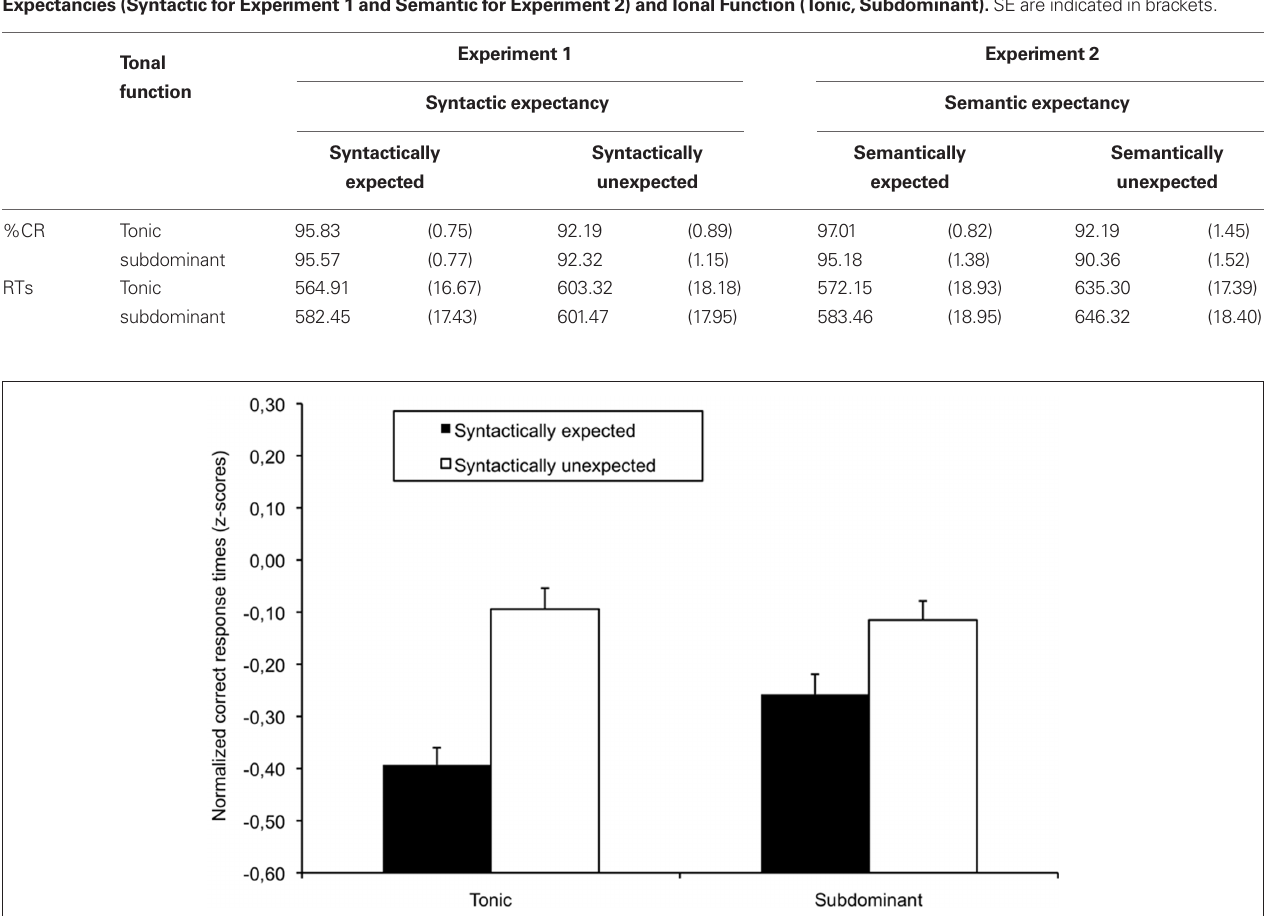
Table 1 | Percentages of correct responses (%Cr) and correct response times (rTs, raw latencies in ms) presented as a function of Linguistic expectancies (Syntactic for experiment 1 and Semantic for experiment 2) and Tonal Function (Tonic, Subdominant). SE are indicated in